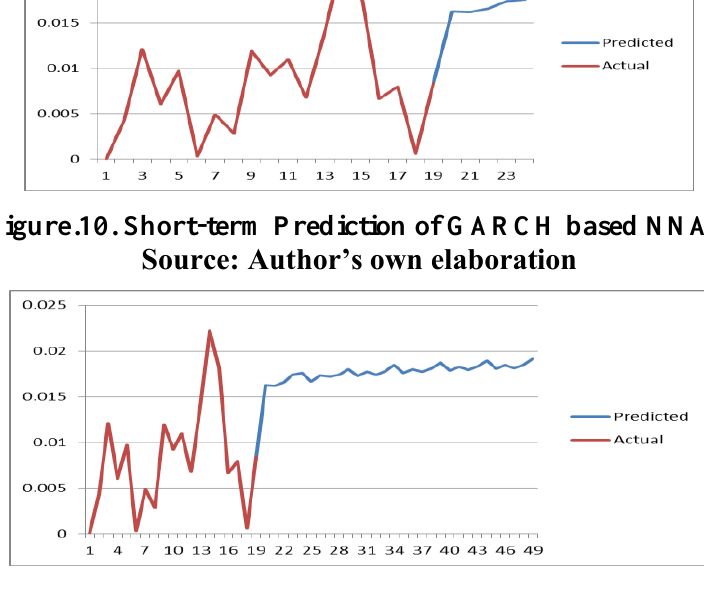
Figure.11. Long-term Prediction of GARCH based NNAR